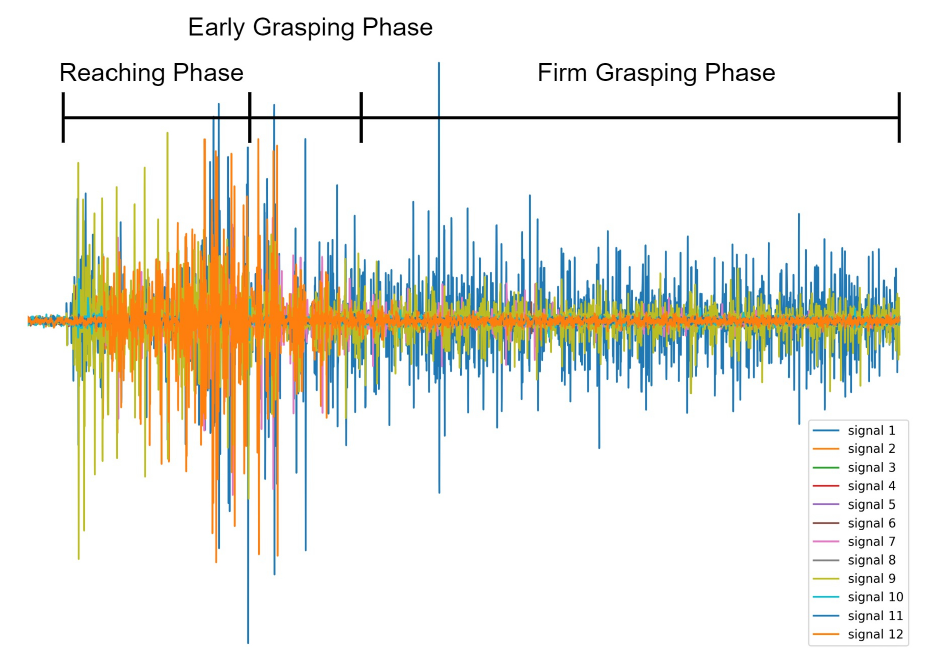
Figure 2. An example of grasp phases overlaid with sEMG signals during a full grasp trial. The start and end positions of these three phases were determined by observing corresponding videos frame by